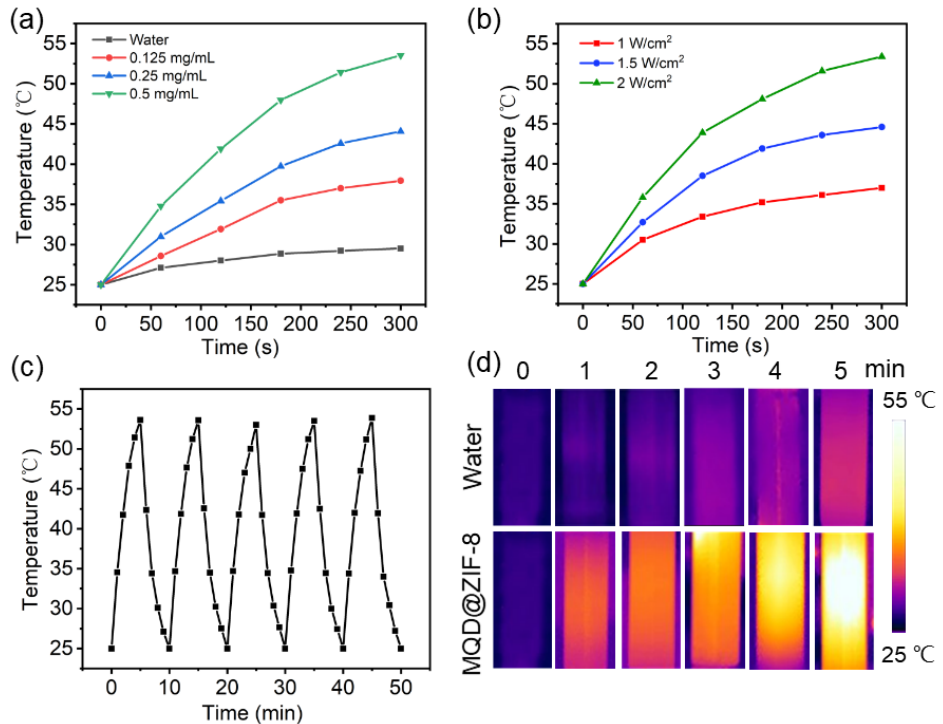
Figure 4. ( a ) Temperature increasing curves of water and different concentrations of MQD@ZIF-8 under irradiation of an 808 nm NIR laser at 2 W/cm 2 . ( b ) Temperature elevation of MQD@ZIF-8 dispersion (0.5 mg/mL) under varied laser power densities of an 808 nm NIR laser. ( c ) Photostability test of MQD@ZIF-8 solution under 808 nm NIR laser irradiation for 5 cycles (2 W/cm 2 , 5 min). ( d ) IR thermal images of water and MQD@ZIF-8 solution after irradiation for 5 min (808 nm, 2 W/cm 2 , 5